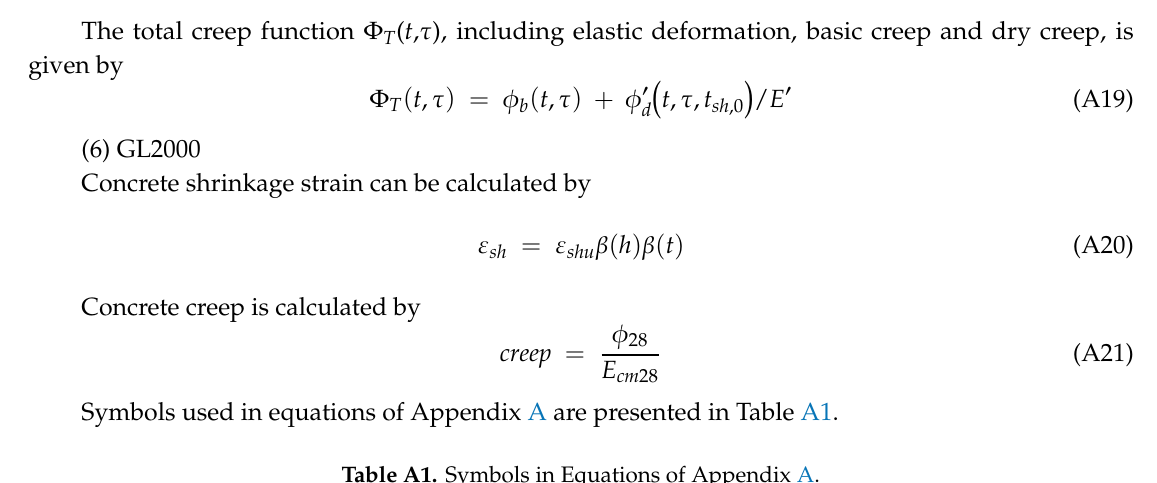
Table A1. Symbols in Equations of Appendix